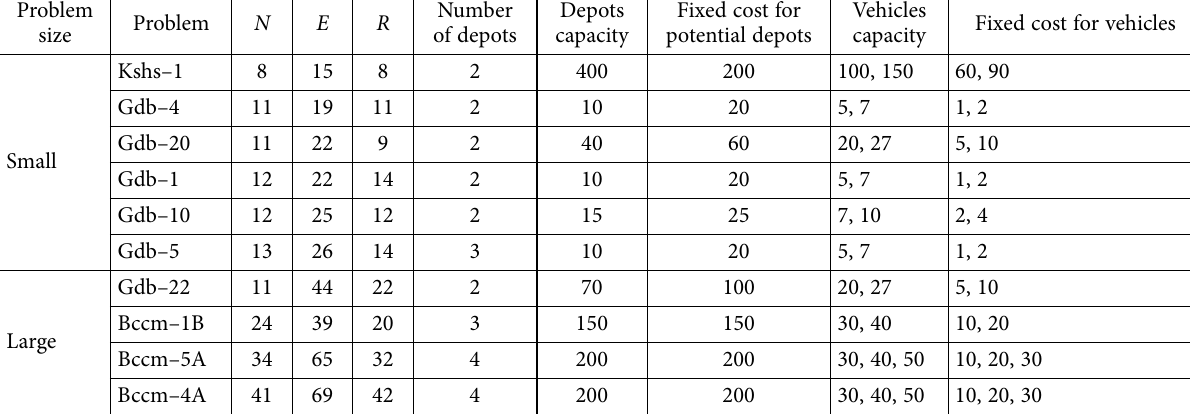
Table 4. Properties of modified instances based on the CARP